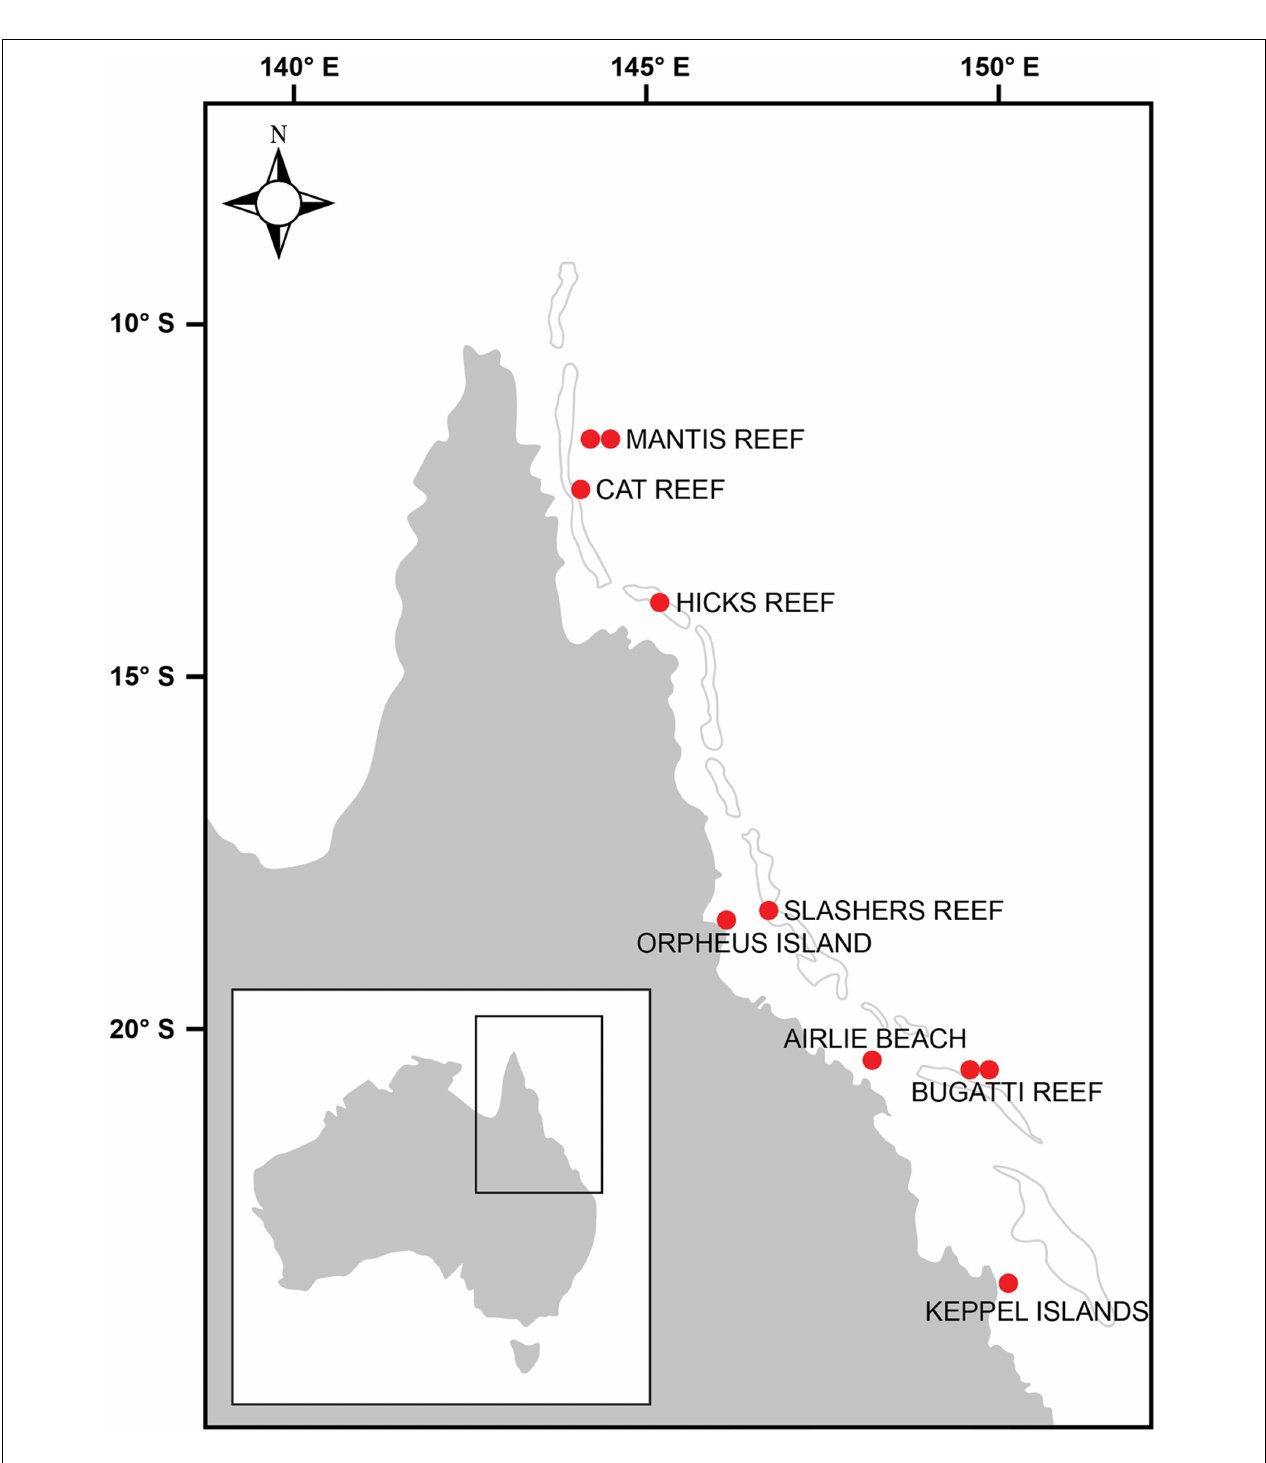
FIGURE 1 | Map of the Great Barrier Reef (GBR) demonstrating the 10 locations where samples were collected from surface waters (5 m) during this